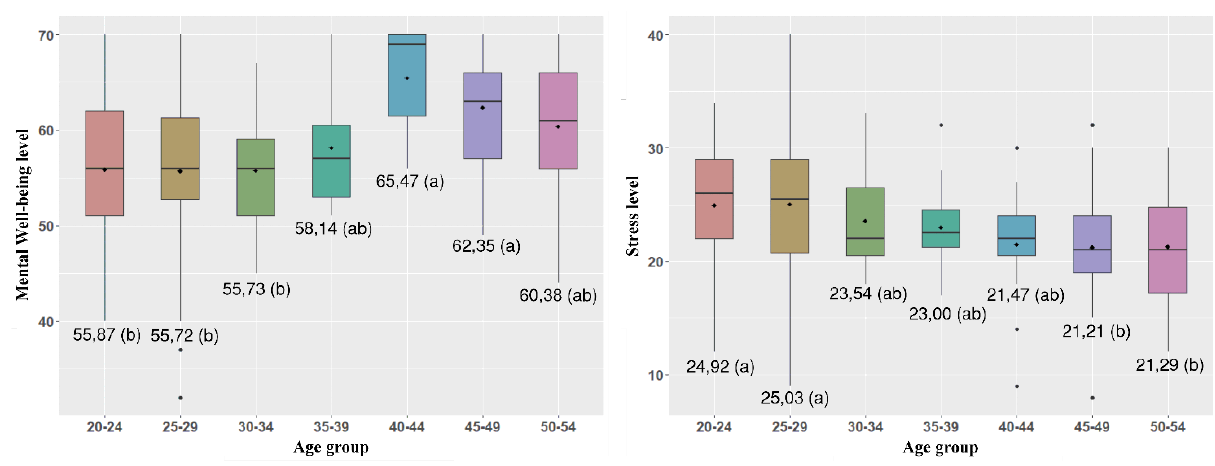
Figure 5. Box plot of age group factor with mental well-being level (left) and stress level (right).